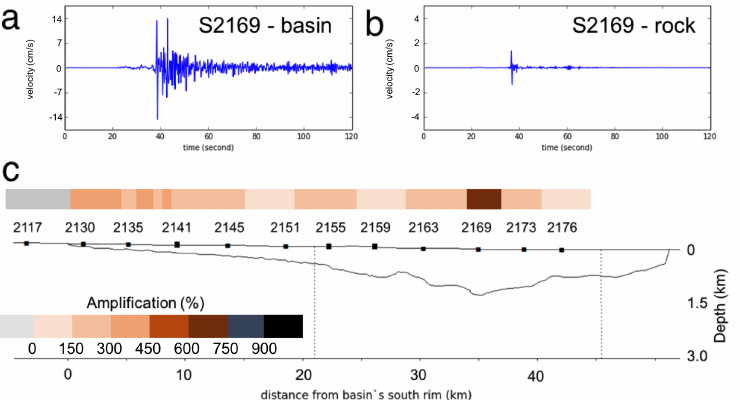
Figure 13. Amplification for the crustal ( a – c ) earthquake scenario, Figure ( a , b ) show velocity seismogram at stations S2169 for basin and bedrock sites respectively, and Figure ( c ) shows PGV amplification at each station along the S-N cross-section for the crustal fault scenario. The cross-section is located at the longitude 108.84335 ◦ and seismograms are the horizontal